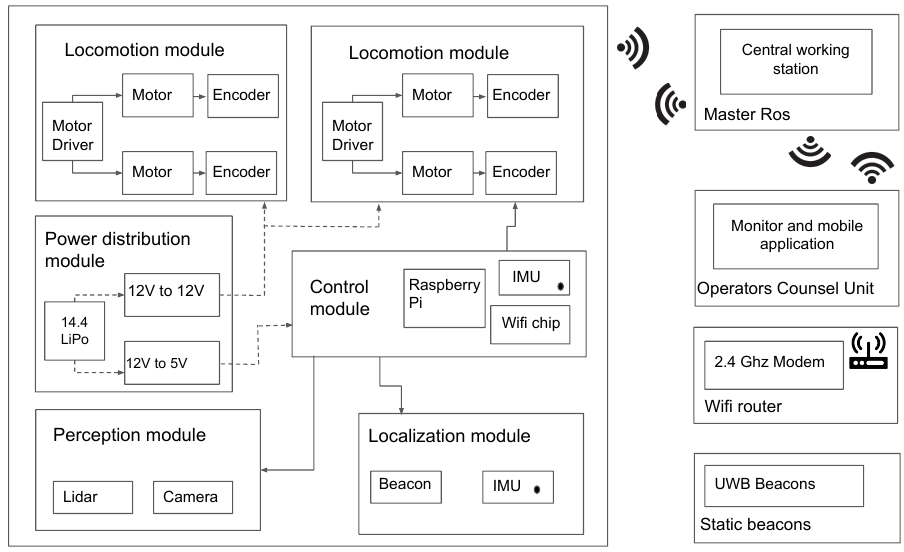
Figure 6. Control